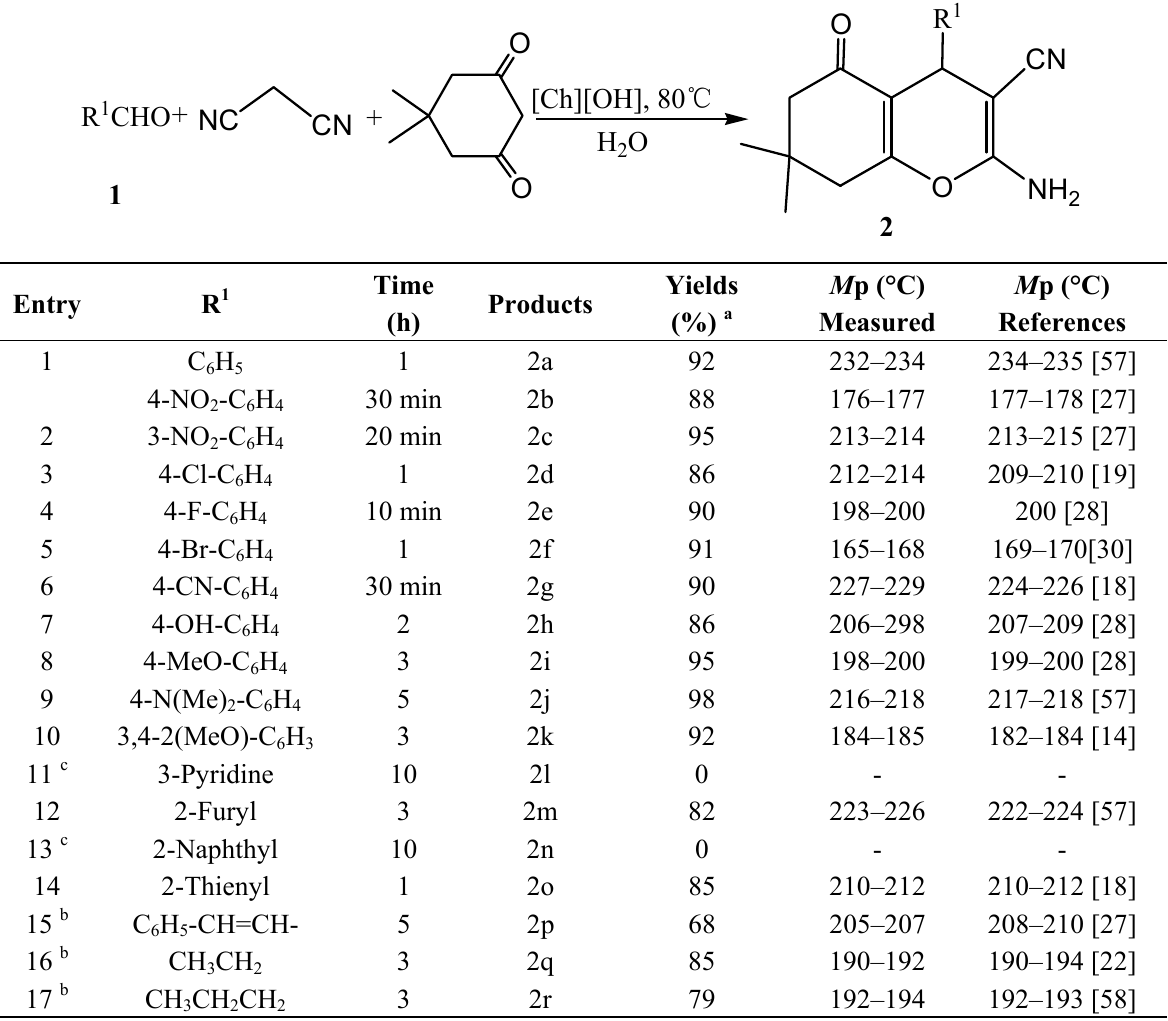
Table 2. Synthesis of pyran derivatives via condensation of aromatic aldehydes, malononitrile and dimedone using [Ch][OH] as catalyst in